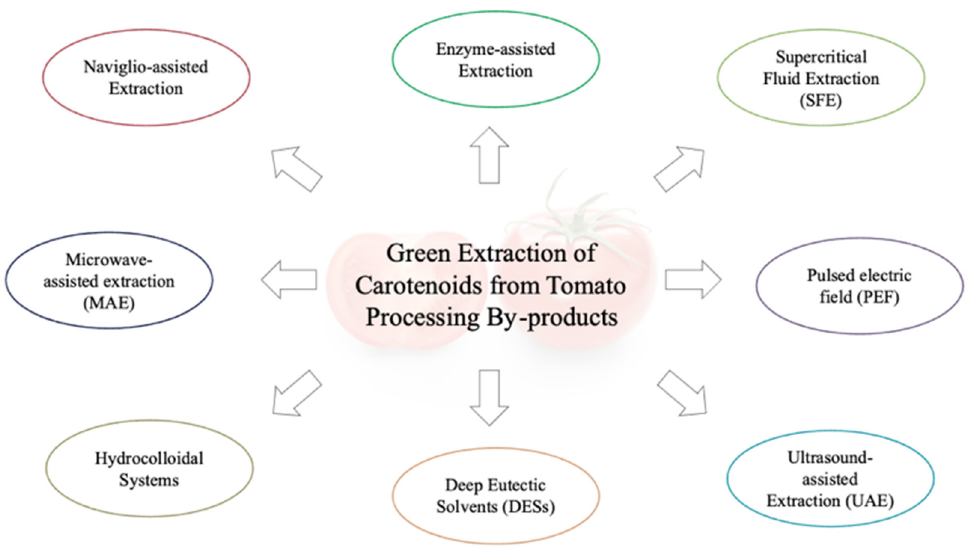
Figure 3. Green extraction methods of tomato carotenoids.